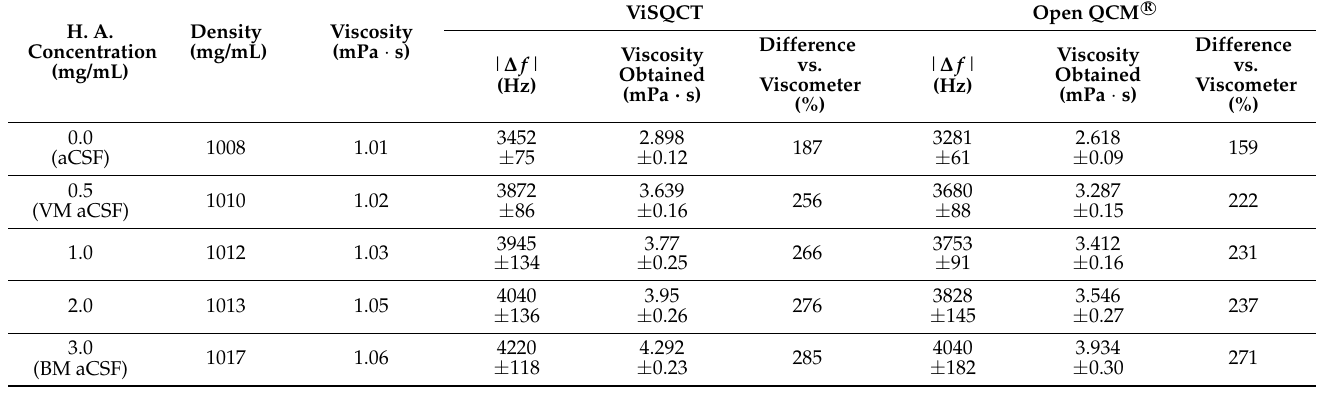
Table 8. aCSF parameters and results with both sensors.